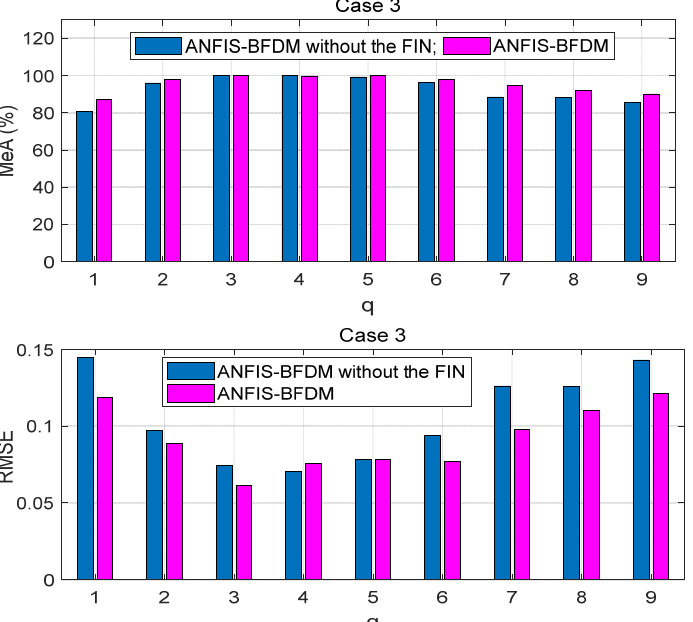
Figure 5. Deriving from the dataset “Case 3” (see Table 2)—the positive role of the filter FIN reflected via the MeA and RMSE of the ANFIS-BFDM in two cases, with/without r ( t ) when q = 1 … 9.